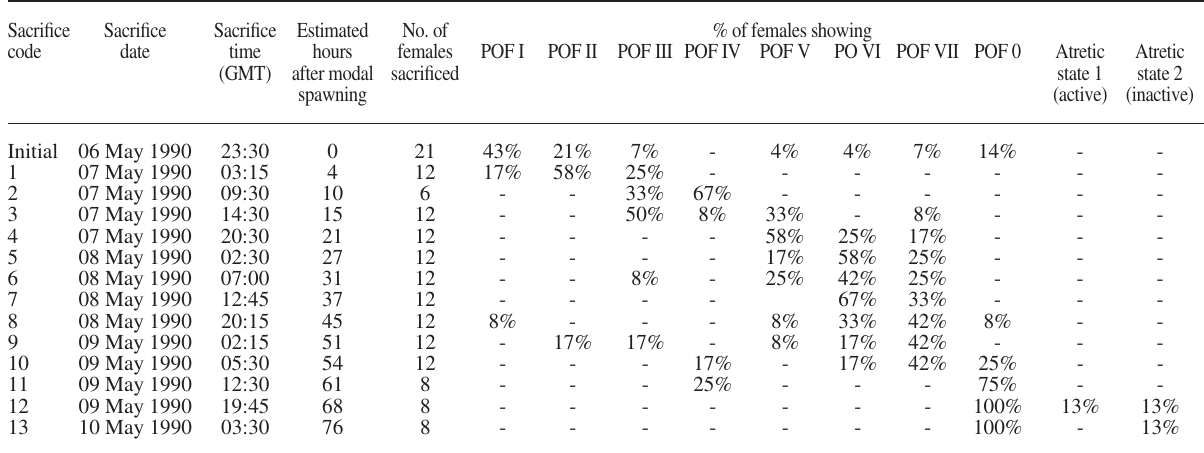
Table 3. – results of the gonad analysis of the females from captivity experiment A (sst range 17-19°c), presented by sacrifices, date and time (gMt) of each sacrifice and elapsed time after assumed modal spawning time. sacrifice sacrifice sacrifice estimated no. of % of females showing code